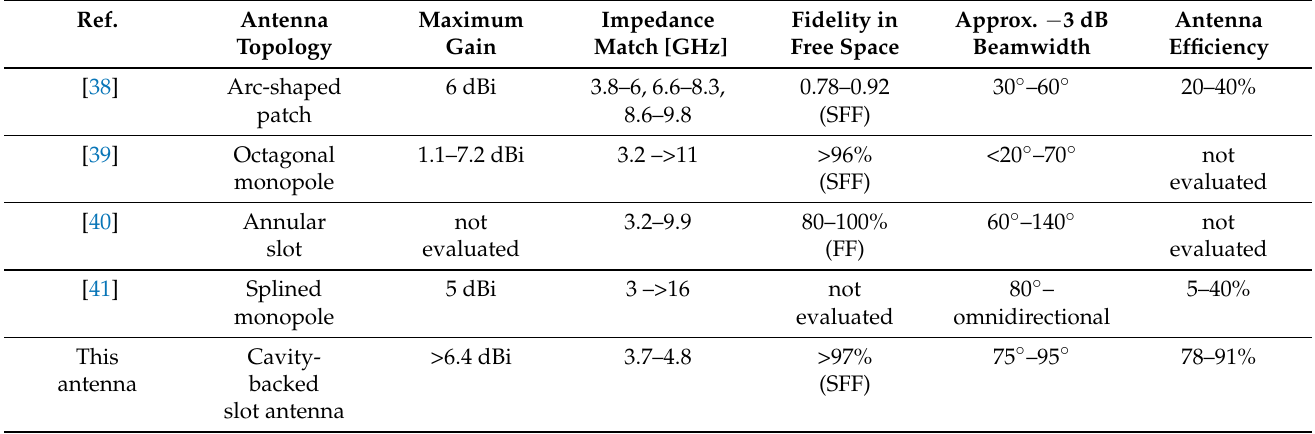
Table 1. Comparison with other ultra-wideband (UWB) antennas throughout literature.